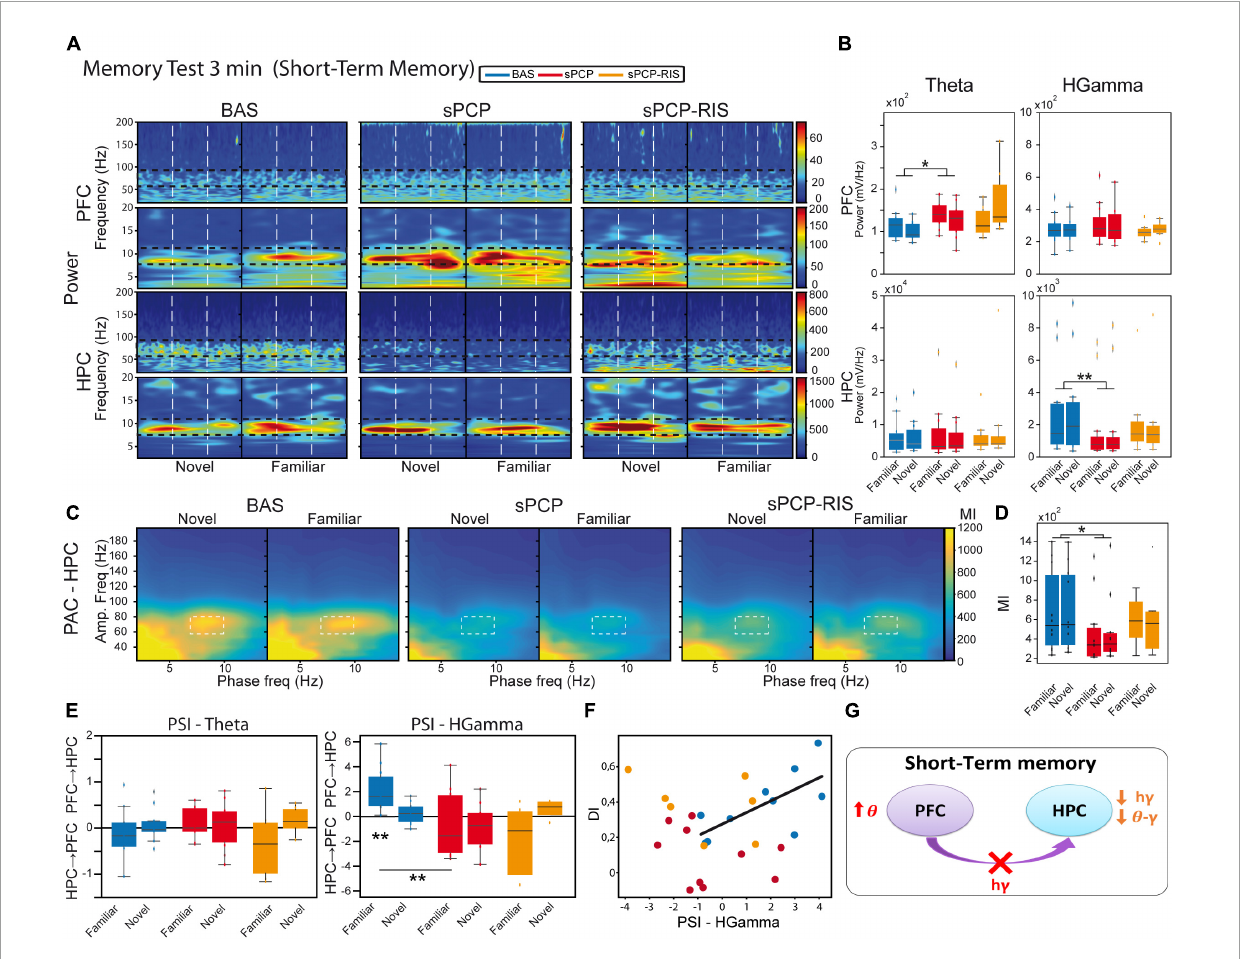
FIGURE4 Neural substrates of short-term memory and effects of sPCP and risperidone. (A) Power spectra in the mPFC and the dHPC during the 3-minute memory test and effects of sPCP and risperidone. Vertical dashed lines mark the first second upon initiation of the visits. (B) Theta and high gamma oscillations were similar during the visits to familiar and novel objects in both regions. sPCP increased theta power in the mPFC non-specifically interfering with the normal theta dynamics ( F ( 1 , 7 ) = 8.26 p = 0.024; mixed ANOVA with object (familiar vs. novel) and treatment (baseline vs. sPCP) as factors). sPCP also reduced dHPC high gamma power ( F ( 1 , 12 ) = 8.37, p = 0.023; differences with sPCP-SAL controls: F ( 1 , 20 ) = 6.44, p = 0.022; mixed ANOVA with object (familiar vs. novel) and treatment (SAL vs. sPCP) as factors) that were partially rescued by risperidone. (C,D) Intrinsic